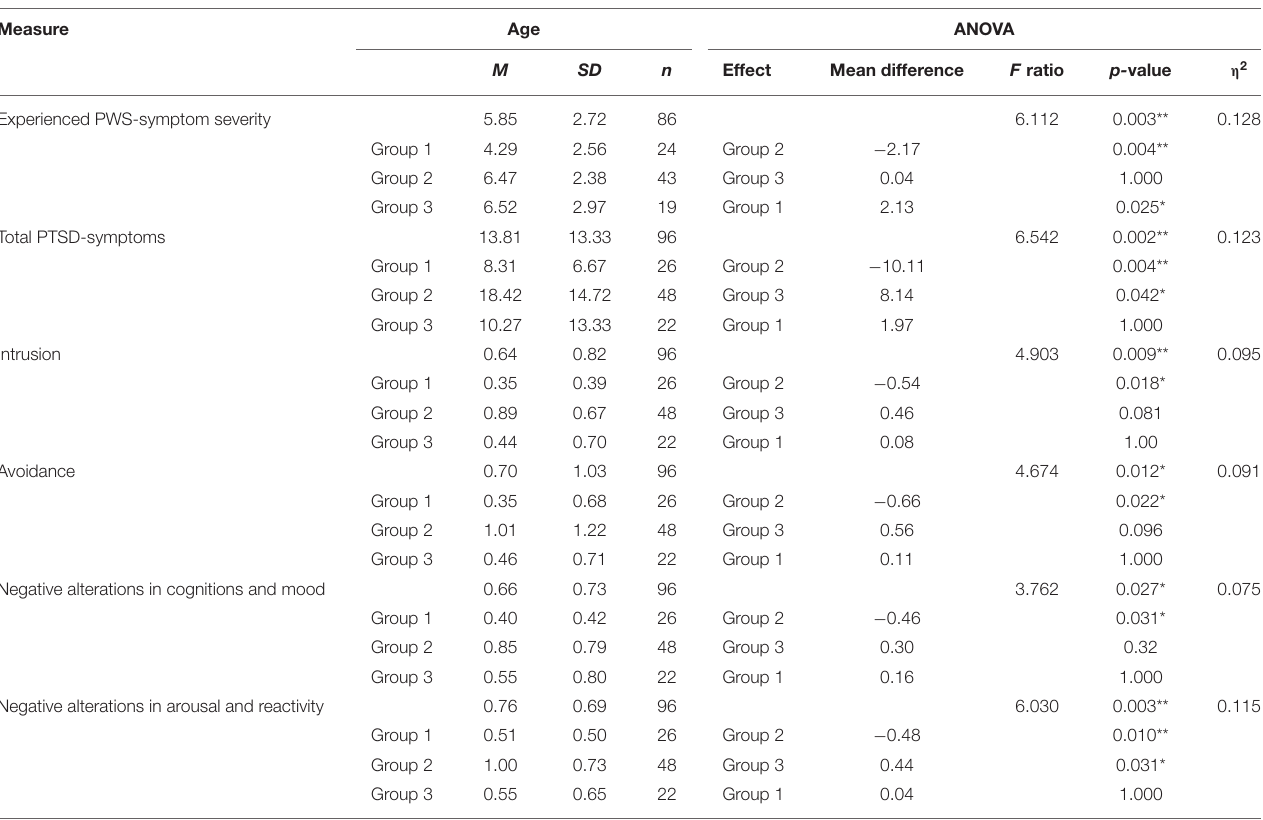
TABLE 5 | Means, standard deviations, and one-way analyses of variance (ANOVA) between age of PWS patients on experienced PWS symptoms, and PTSD symptoms, in family members.